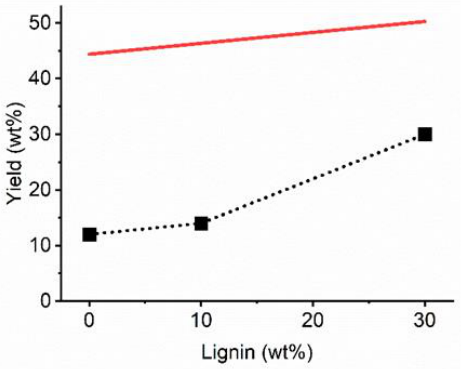
Figure 8. The gravimetric CF yield after batchwise conversion as a function of lignin content in the System S precursor. The red line shows the theoretical carbon yield based on the carbon content of the raw materials.